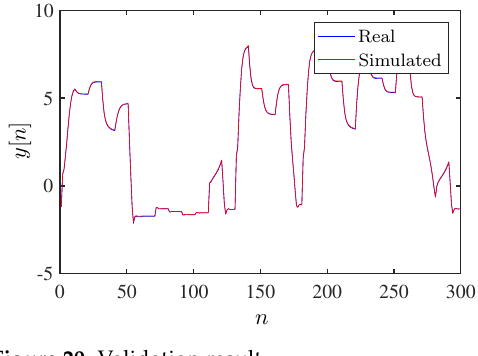
Figure 20. Validation result.